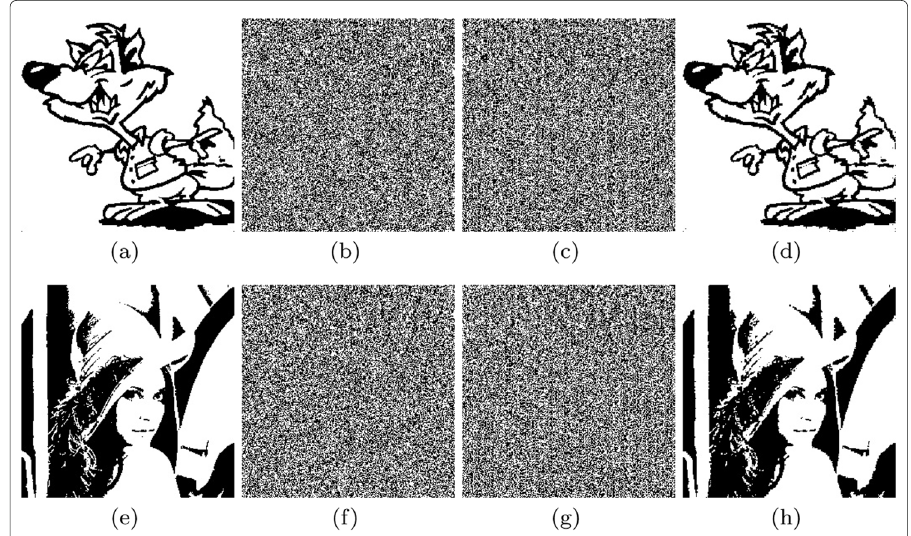
Fig. 7 Testing the effectiveness of proposed method with Cartoon and Lena. The first column is the original image ( a , e ), the second column is their encrypted version ( b , f ), the third column is the encrypted image containing additional data ( c , g ), and the forth column is the recovered image ( d , h